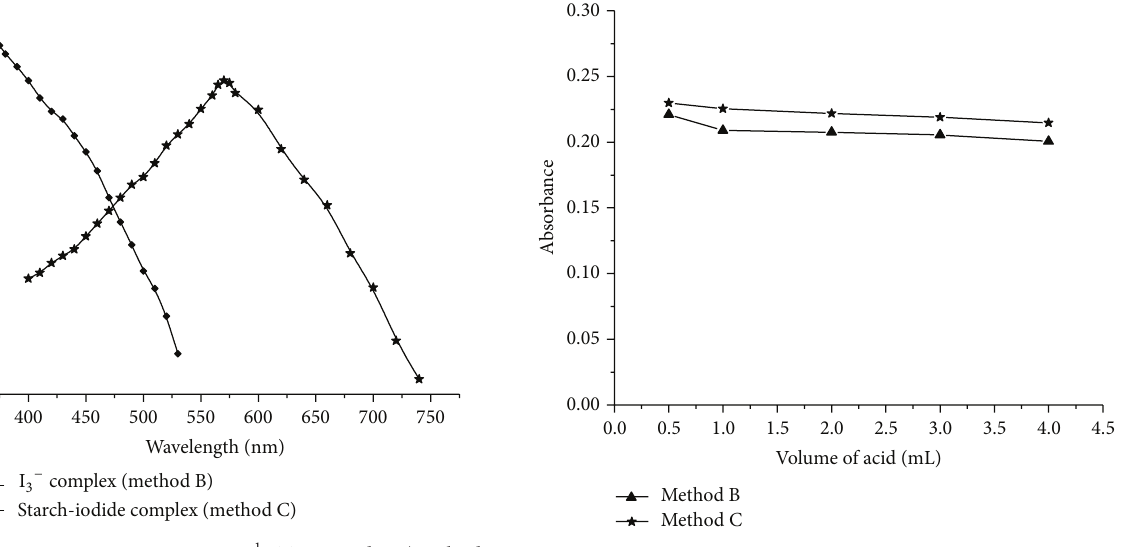
Figure 3: Effect acid concentration on 12 𝜇 gmL −1 STS (method B) and 3 𝜇 gmL −1 STS (method